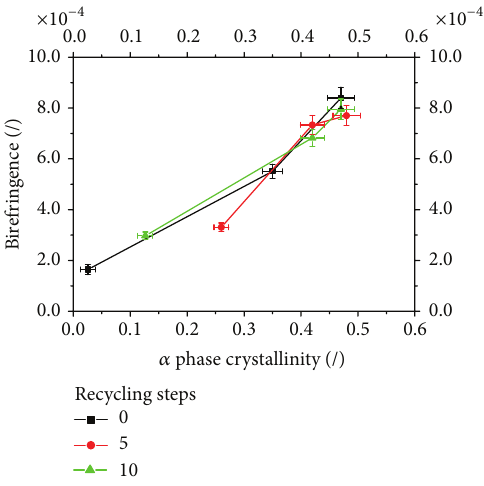
Figure 7: Measured birefringence of all the samples reported versus the amount of 𝛼 phase of each film.